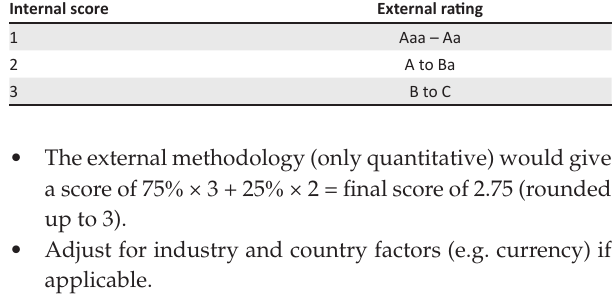
TABLE 6: Mapping from the internal score to the external rating (illustrative example). Internal